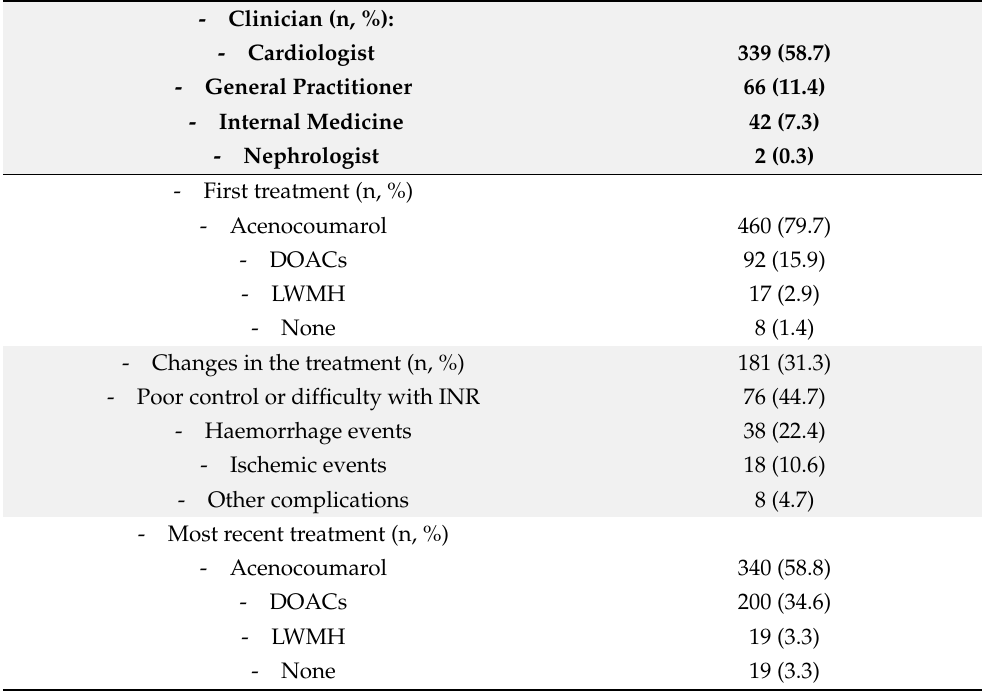
Table 2. Anticoagulants prescribed for the treatment of atrial